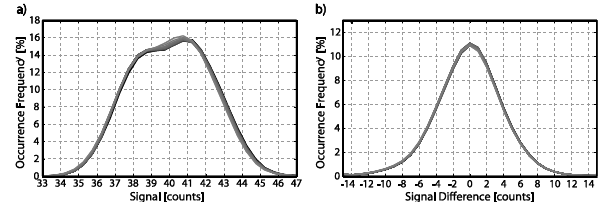
Figure 4. (a) Occurrence frequency of signal measured in a dark Fig. 4. (a) Occurrence frequency of signal measured in a dark room for 25 different 3 room for 25 different integration times, ranging from 1ms (black) integration times, ranging from 1ms (black) to 2s (lightest gray). Ten exposures at 4 to 2s (lightest gray). Ten exposures at each integration time were each integration time were averaged to construct each histogram. (b) Occurrence 5 averaged to construct each PDF. (b) Occurrence frequency of the frequency of the signal in a single frame for the 25 integration times with an average 6 signal in a single frame for the 25 integration times with an average 1ms frame subtracted. Individual labels for each integration time were not added 7 1ms frame subtracted. Individual labels for each integration time because curves are not discernable. 8 were not added because curves are not discernable.